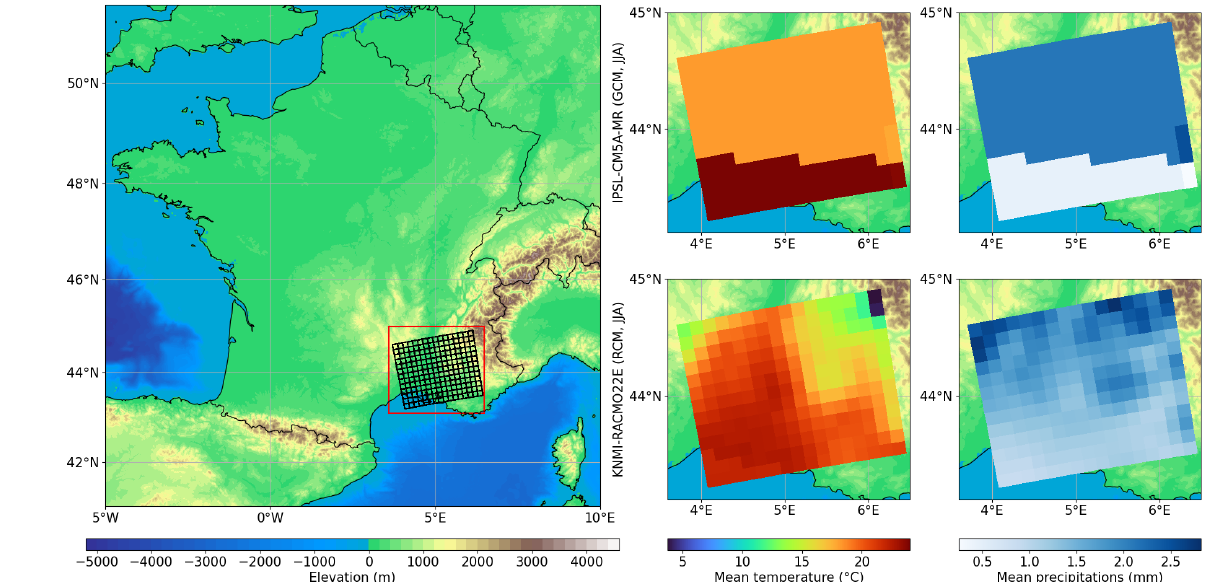
Figure 1. Left panel: map of elevation (in m) over France. The region of interest lies in the south-east box. Right panels: mean summer (JJA) temperature (in ◦ C) and precipitation (in mmd − 1 ) for the region of interest (top: IPSL-CM5A-MR; bottom: KNMI-RACMO22E) over 1951–